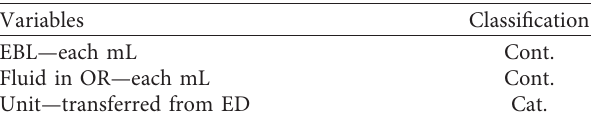
Table 1: List of all variables included in regression